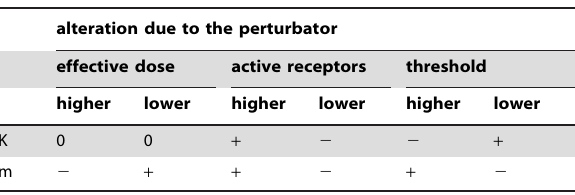
active receptors threshold r 2 : correlation coefficient between observed and predicted results. See also Table 1 and Figure 4. Number of active receptors ( a ) and threshold ( l ) are defined by means of aleatory Weibull numbers. Doses and perturbator concentrations varie in the natural domain [0-(20)-200] and are coded in the domain [0-(0.1)-1]. p e coefficients –which operate on natural values of D, a and Maximum slope, r m , varies according to (8), but the parameter a remains l – are those defined in (11). Arrows indicate increase ( q ) and decrease ( Q ) of constant in all cases. the affected element.